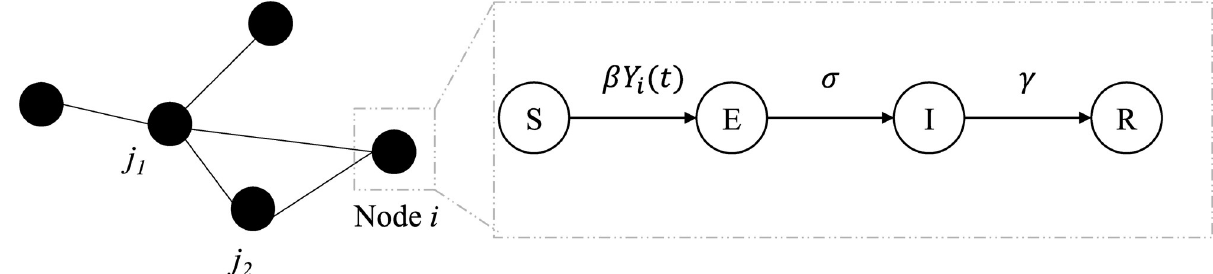
Fig 8. ASF epidemic model. The network based SEIR epidemic model for African swine fever virus. The black solid circles indicate host nodes (individual pigs) and the solid lines connecting them indicate contacts (direct or fomites) that can act as infection pathways of ASFV. Each node can be in any of the four states, Susceptible ( S ), Exposed ( E ), Infected ( I ), or Recovered ( R ). The rates at which a host can move from one state to another are indicated by the parameters (See Table 5) adjacent to corresponding arrows. Here, Y ( t ) is the number of infected contacts of node i at time t . i